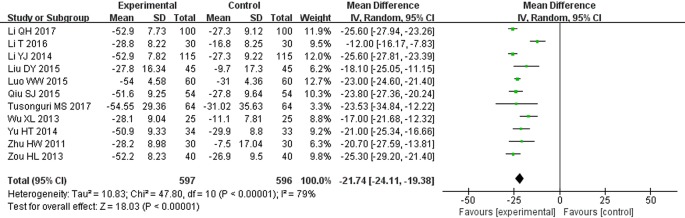
Meta-analysis for comparison of serum creatinine (SCr) levels between the experimental and control groups.